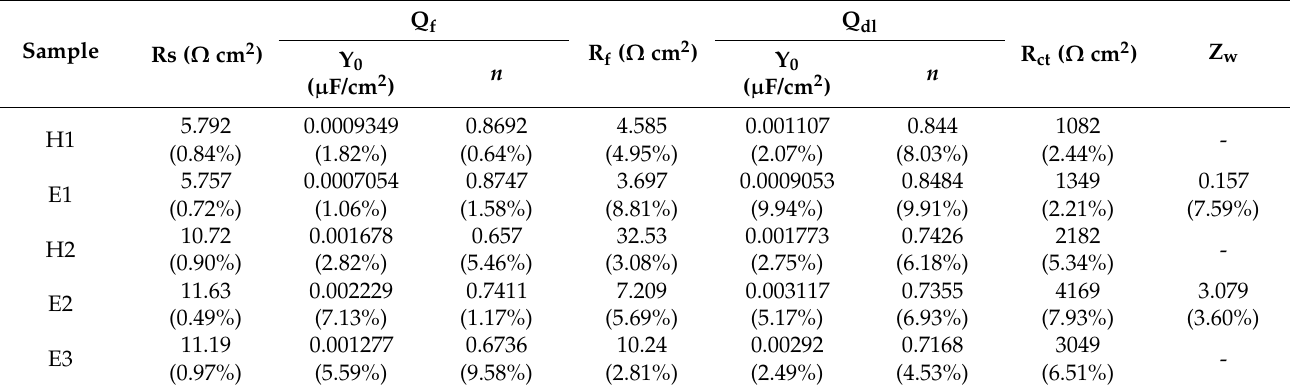
Figure 13. EIS results: ( a ) Nyquist plots of H1 and E1; ( b ) Bode plots of H1 and E1; ( c ) Nyquist plots of H2, E2 and E3; ( d ) Bode plots of H2, E2 and E3; ( e ) fitting models of equivalent circuit. Table 7. Equivalent circuit parameter